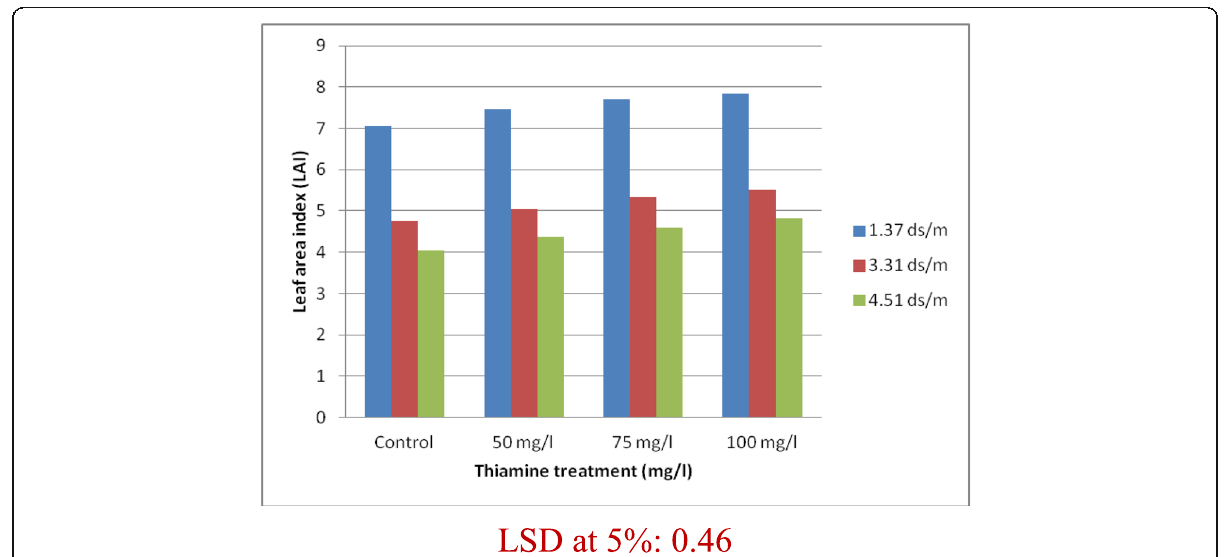
Fig. 4 Effect of the interaction between salinity levels and thiamine levels on LAI of faba bean at 90 days from sowing (combined analysis of two